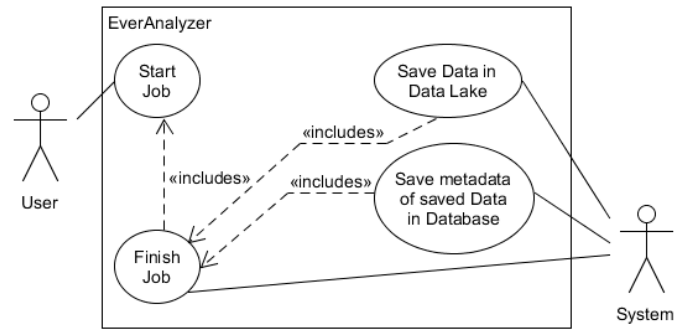
Figure 9. Use Case diagram of EverAnalyzer Objective #3.